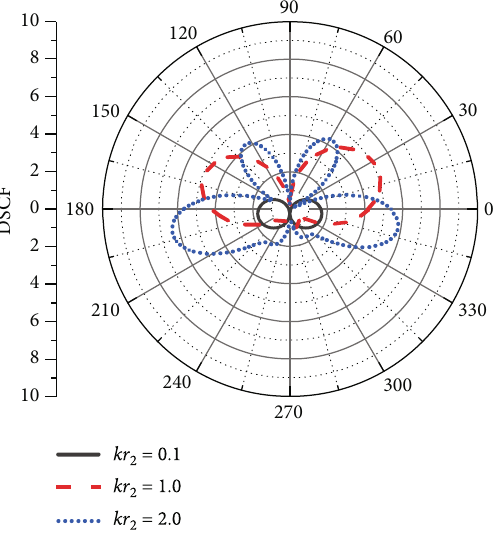
Figure 5: DSCF distribution of the circular hole at di ff erent frequencies ( d / r 2 = 8 : 0 and h / r 2 = 7 : 0 ).